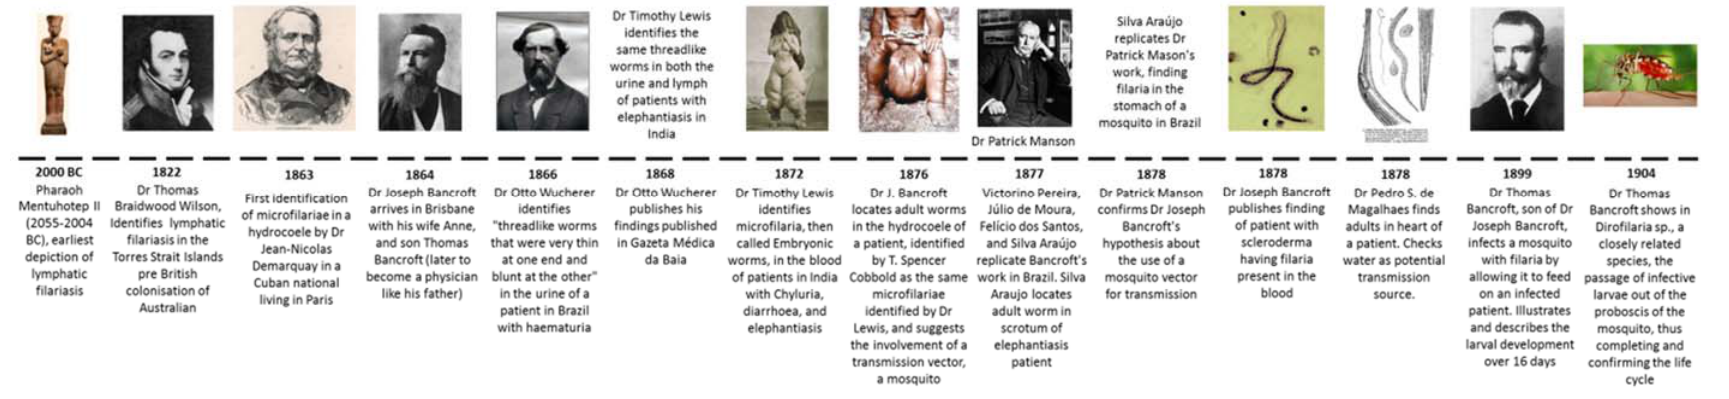
Figure 1. Timeline of Bancroftian filariasis showing the earliest known record in the form of a statue of Pharaoh Mentuhotep II (2055–2004) and through to the elucidation of the lifecycle finalised in 1904 by Dr. Thomas Bancroft.